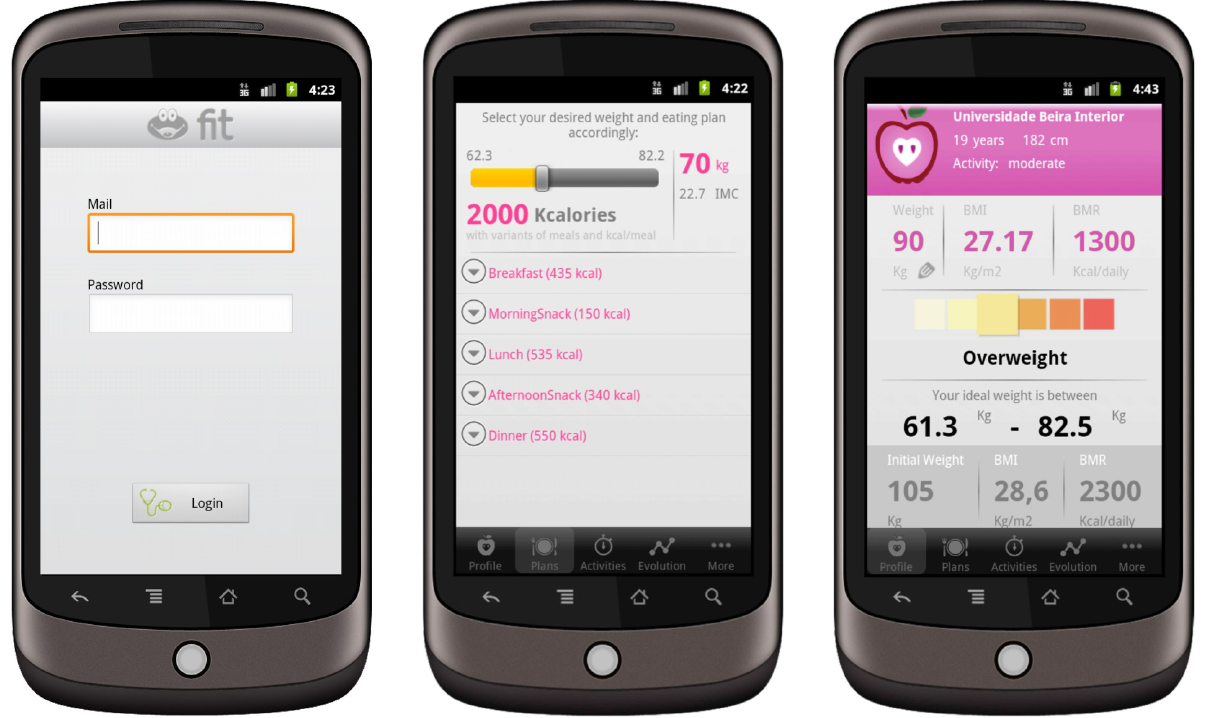
Figure 2. Screenshots of the three main activities of SapoFit app: Login, Plans, and User